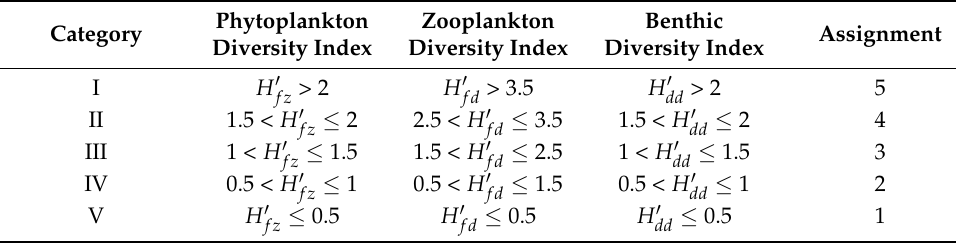
Table 2. Classification and evaluation standards of aquatic biological